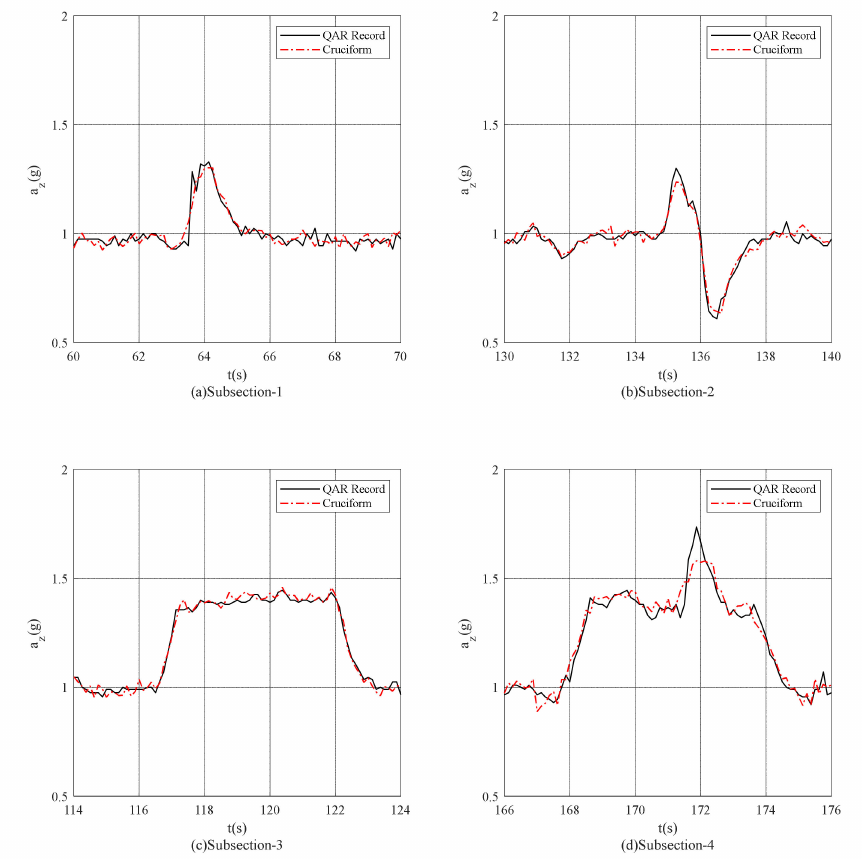
Figure 10. Record and calculated vertical acceleration response: ( a ) the comparison between the recorded acceleration and the computations results in subsection-1; ( b ) the comparison between the recorded acceleration and the computations results in subsection-2; ( c ) the comparison between the recorded acceleration and the computations results in subsection-3; ( d ) the comparison between the recorded acceleration and the computations results in